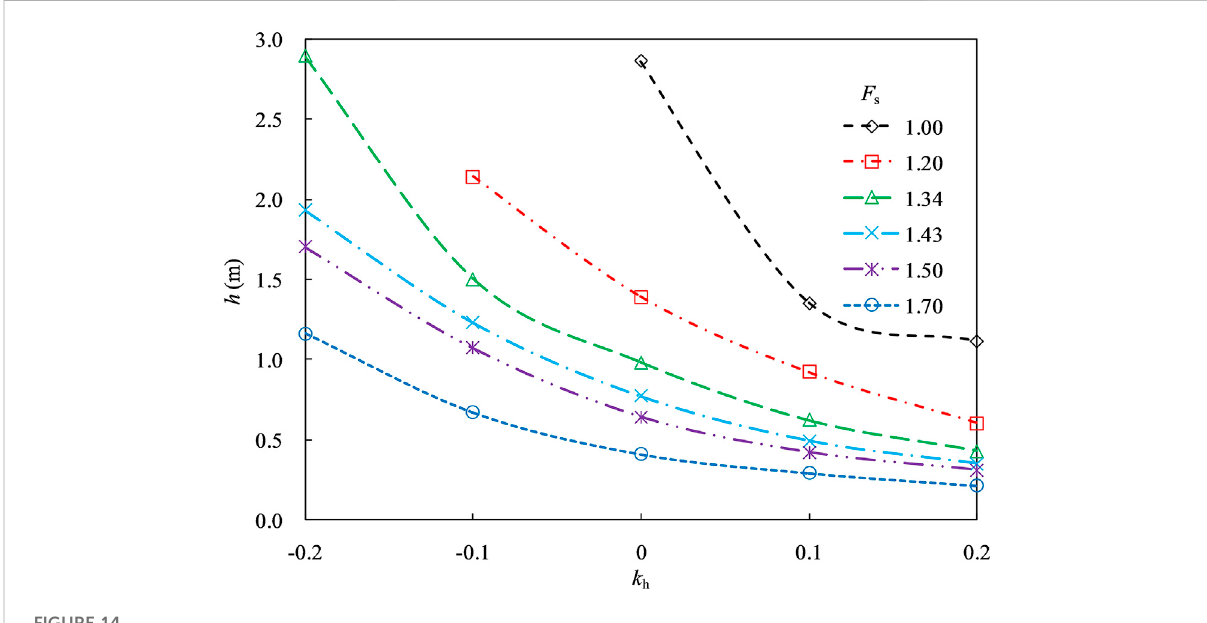
FIGURE 14 Relationship between h and k h under different F s .